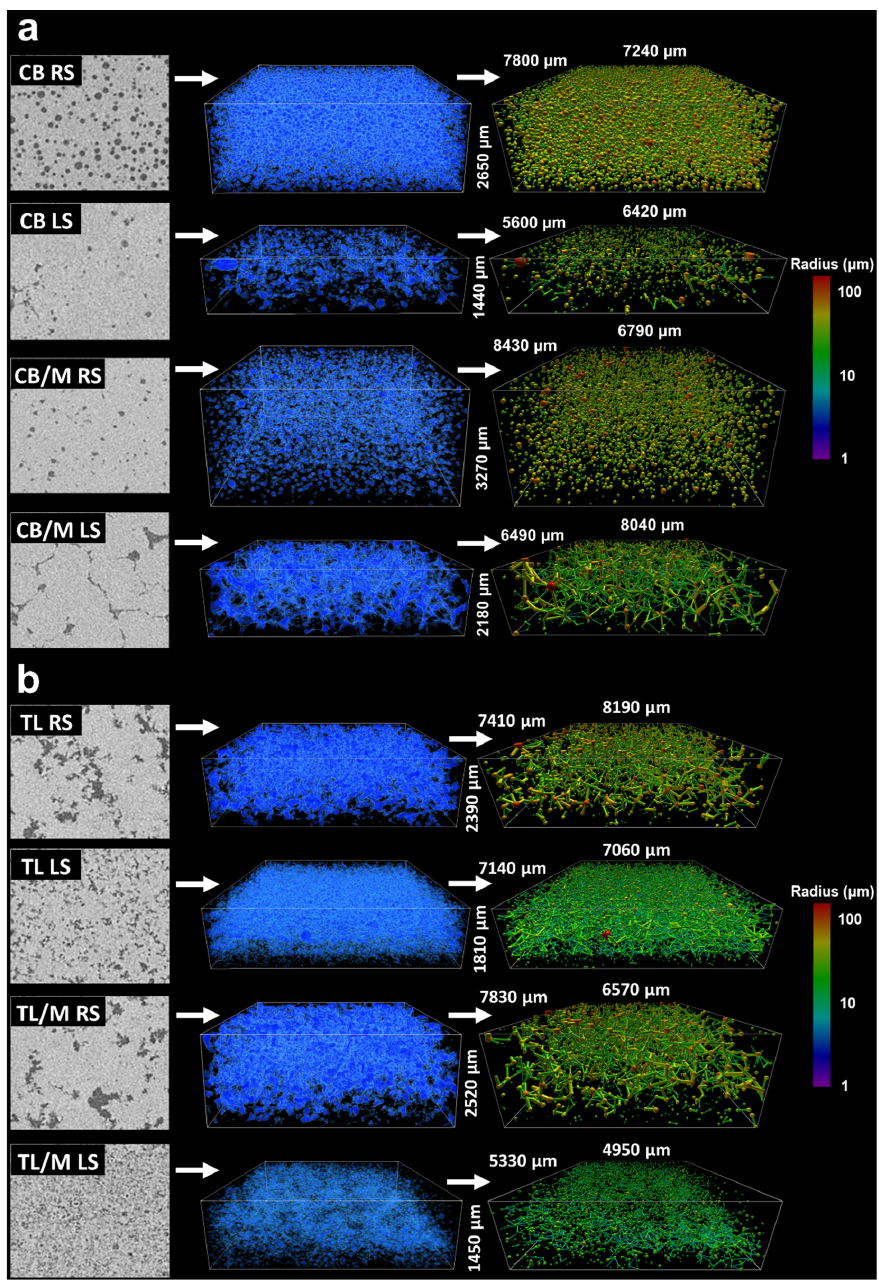
Figure 4. Pore network visualizations for 500 s − 1 sheared samples, ( a ) cocoa butter and ( b ) trilaurin. Images corresponding to each sample are depicted as (Left) CT image slices, (Middle) raw 3D plots (blue) of void voxels prior to analysis, and (Right) a 3D ball and stick plot of pores and throats after MB analysis. Pores and throats are colored according to radius measurements on a log 10 scale.